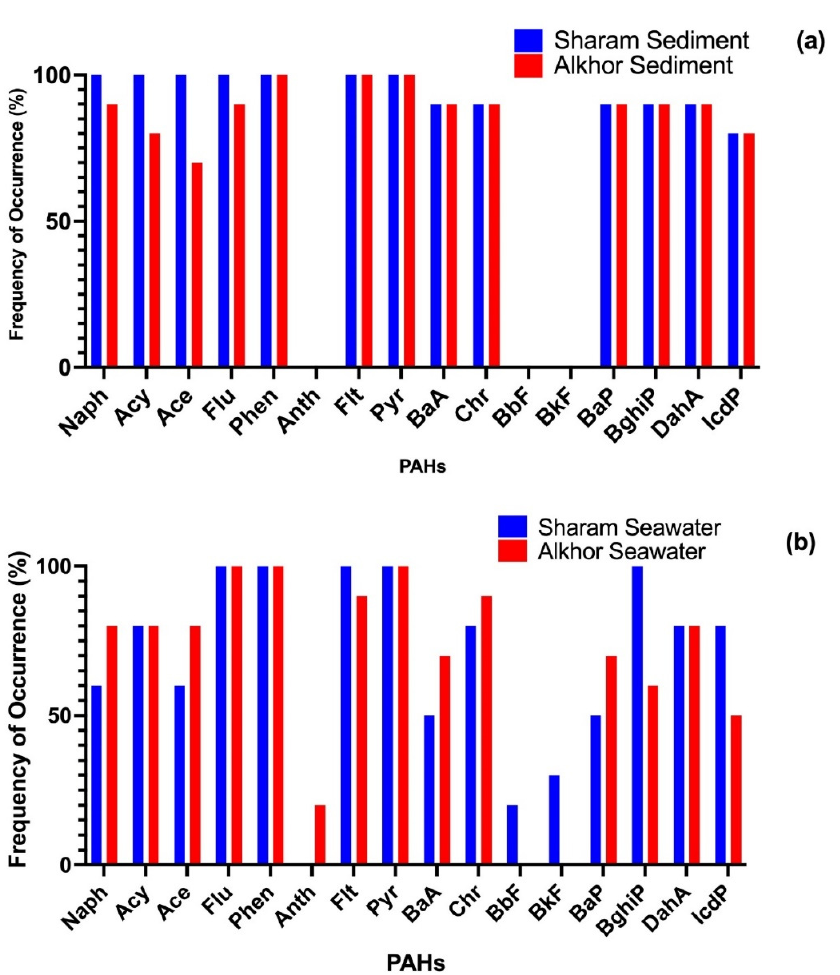
Figure 2. Frequency of occurrence (%) of PAHs in sediment and water samples from the Sharam area and Alkhor area. ( a ) represents sediment samples, ( b ) represents seawater samples.